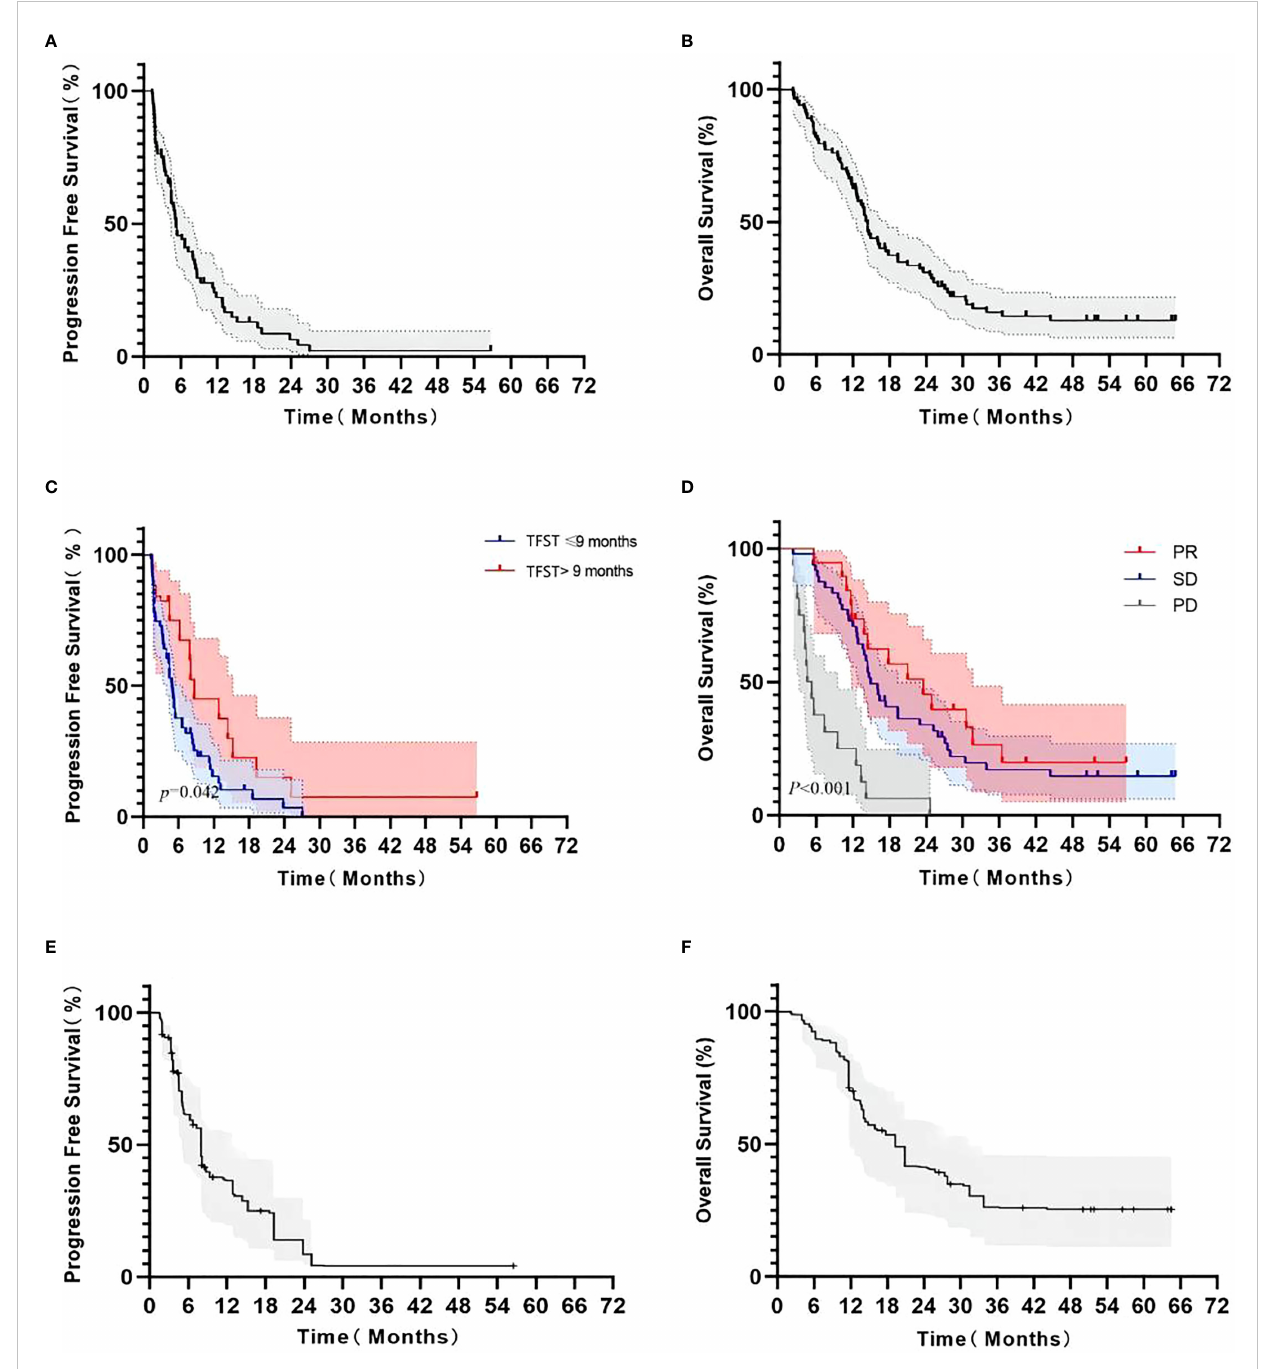
FIGURE 2 Kaplan – Meier survival curve in advanced NSCLC patients receiving second-line S-1-based doublet chemotherapy. Progression-free survival (A) ; overall survival (B) ; PFS according to the TFST from fi rst-line chemotherapy (>9 months and ≤ 9 months, (C) ; OS according to response from second-line chemotherapy (PR, SD, and PD, (D) ; adjusted PFS by weight matching (E) ; adjusted OS by weight matching (F)